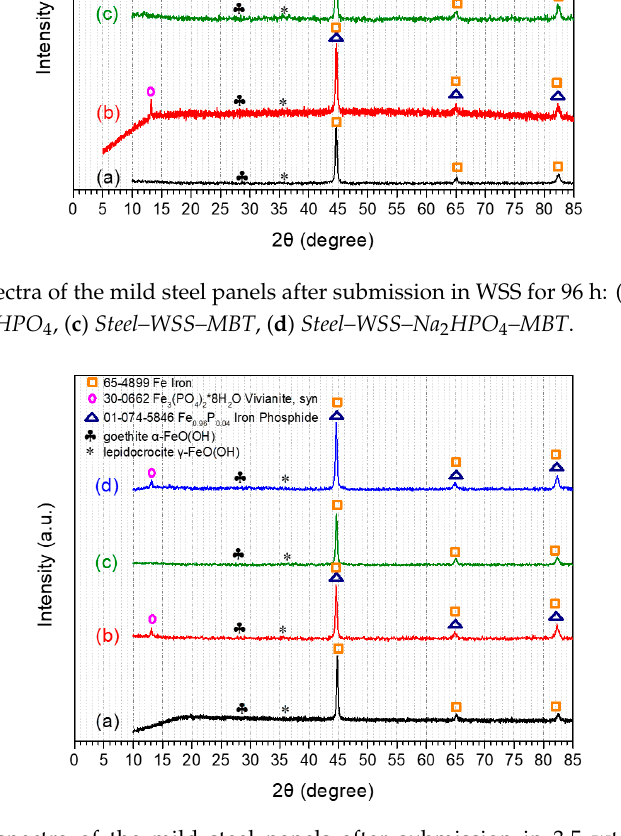
Figure 13. XRD spectra of the mild steel panels after submission in WSS for 96 h: ( a ) Steel–WSS–blank ,